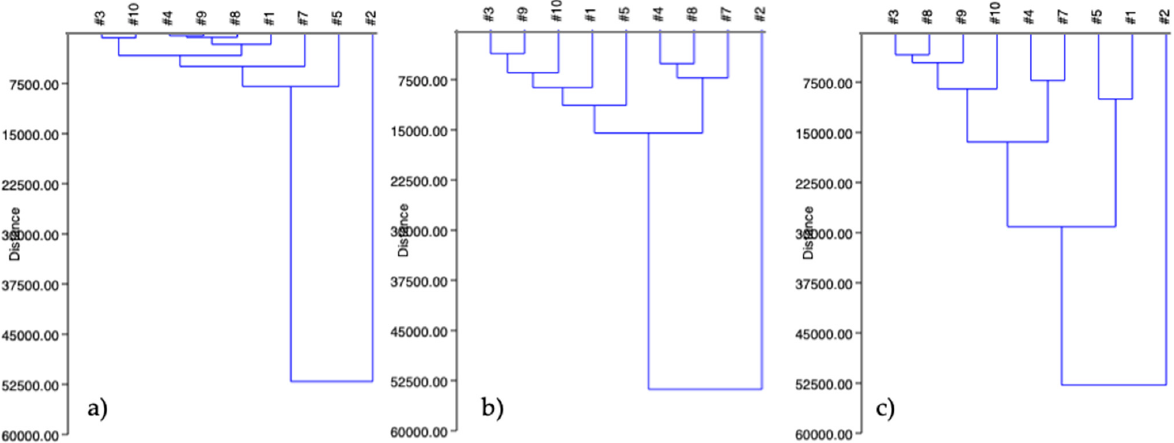
Figure 3. Bubble graph of the leaching tests performed on the different samples. Each bubble is the average of the concentrations determined for each sample in the leaching tests, after normalization. The red bubbles identify the test performed after 24 h, the yellow bubbles after 7 days, and the black circles after 15 days.